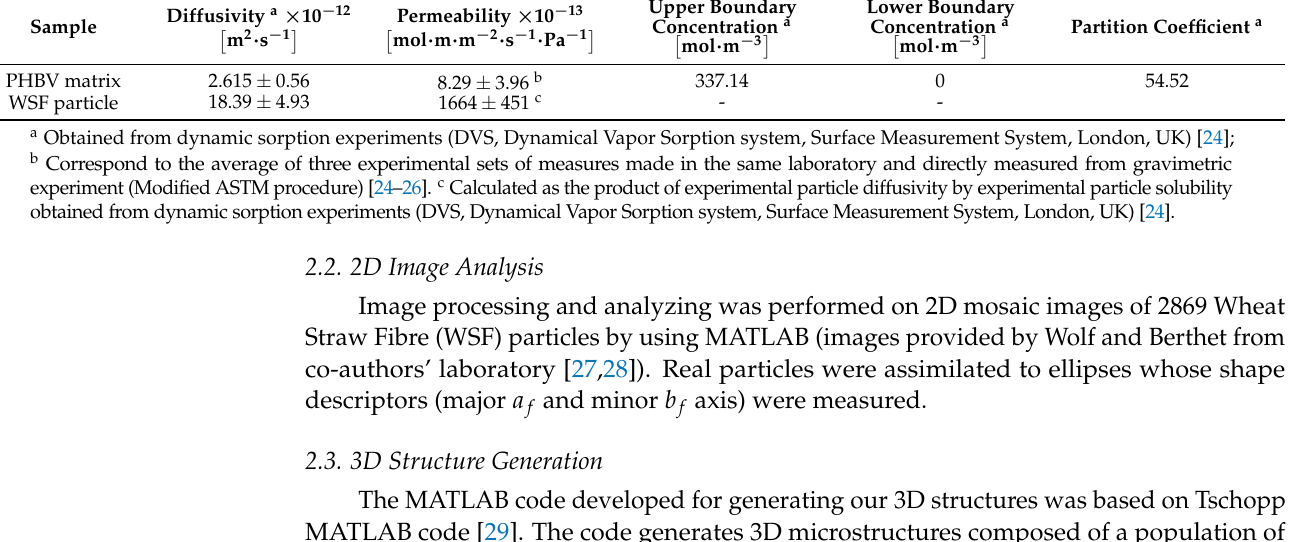
Table 1. Summary of the experimental parameters for water vapor transfer used in this work. Sample